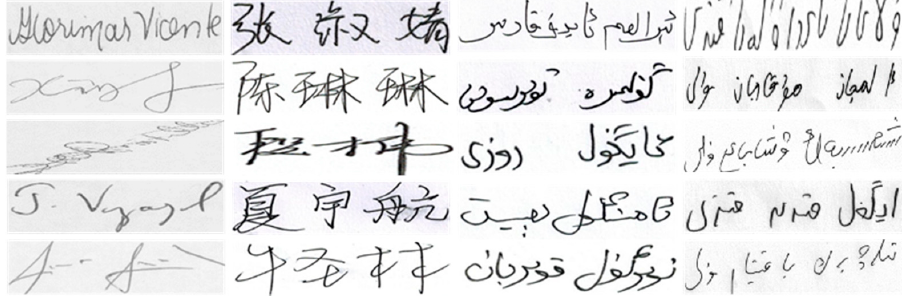
Figure 2. Some multilingual offline signatures; an example of partial genuine signatures in CEDAR, Chinese(Han), Uyghur, and Kazakh languages.